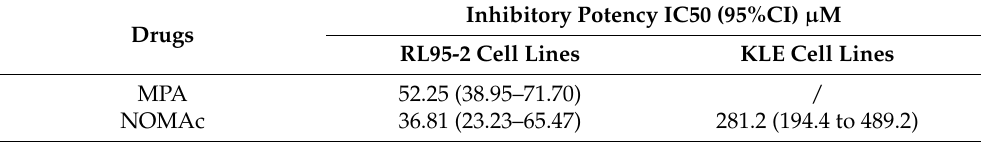
Table 1. Antiproliferative activity of MPA and NOMAc on RL95-2 and KLE cells after treatment for 48